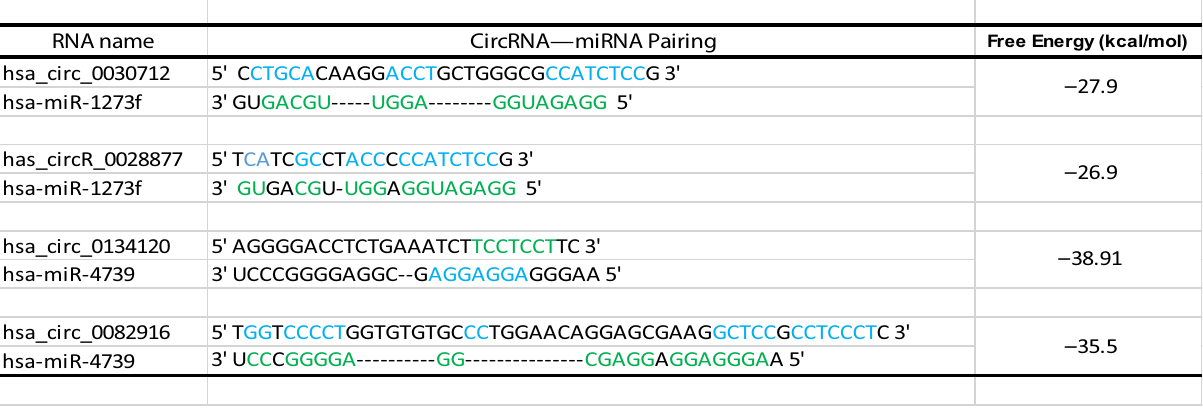
Table 3. Predicted circRNA–miRNA binding sites and activity. The blue and green bases represent binding sites between miRNAs and circRNAs.